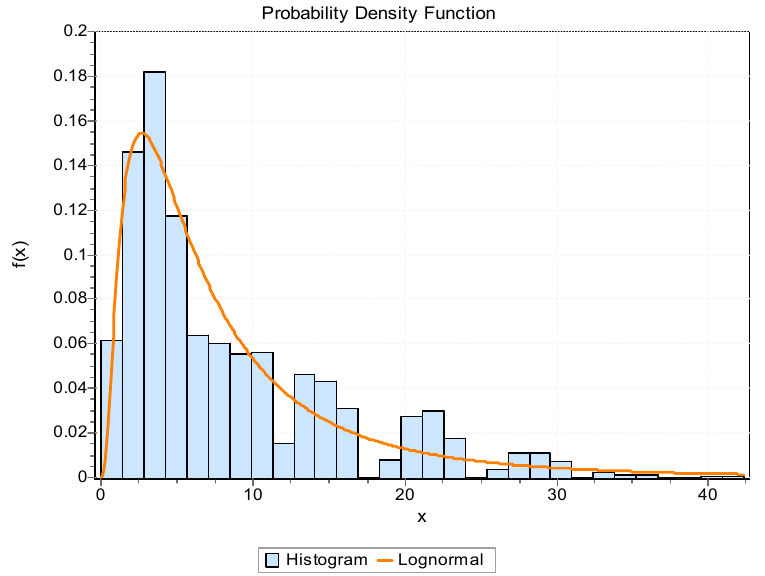
Figure 8. Average random slow fading approximated with 2-P probability distribution with respect to EDH climatology at 40 km distance.